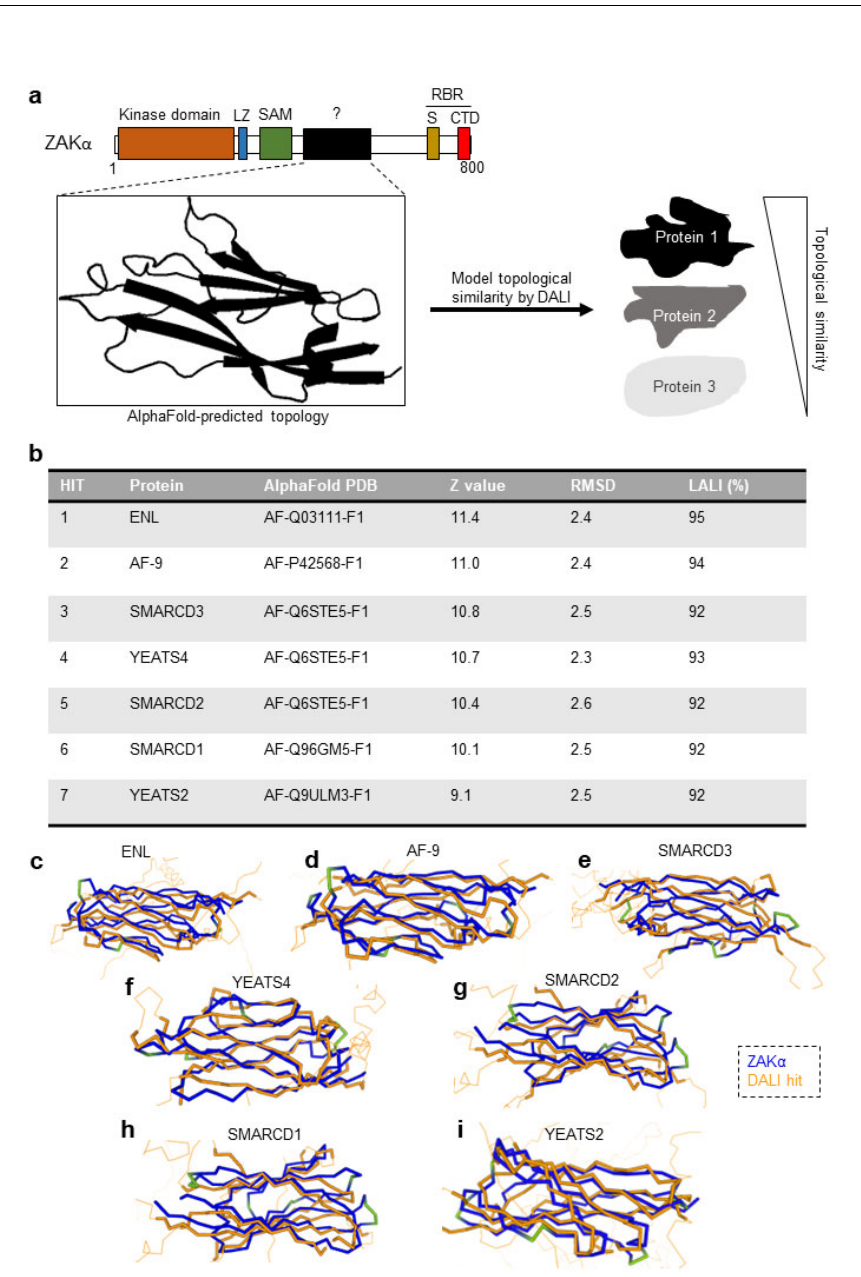
Figure 3. The unannotated ZAK α domain shares topological similarities with other proteins. ( a ) Schematic of the distance-assisted matrix alignment (DALI) method for structural comparison. A PDB fi le containing 3D coordinates of amino acids 433–550 in ZAK α was analyzed by the DALI web server for topological conservation against the human AlphaFold database. LZ, Leucine Zipper; SAM, Sterile Alpha Motif; S, Sensor Domain; CTD, C-Terminal Domain; and RBR, Ribosome Bind- ing Region. ( b ) The top seven ZAK α -DALI hits (Z value > 9) from the hierarchical pairwise DALI analysis against the AlphaFold database. Z-values, root mean square deviation (RMSD), and num- ber of equivalent residues (LALI) are listed. ( c – i ) C α -C α atom traces for amino acids 433–550 in ZAK α (blue/green) superimposed on DALI hits: ENL ( c ), AF-9 ( d ), SMARCD3 ( e ), YEATS4 ( f ), SMARCD2 ( g ), SMARCD1, ( h ) and YEATS2 ( i ) (all colored orange). Thick orange C α -traces of the DALI hits represent traces that superimpose with the unannotated ZAKa domain, whereas thinner orange C α -traces of the DALI hits represent unaligned parts of these proteins. The overlays were made in the DALI web server and inspected using PyMOL as described in Section 2.4. ZAK α traces are colored in a monochrome conservation color with blue indicating strong superimposition and green regions indicating poor superimposition on DALI hit structure.